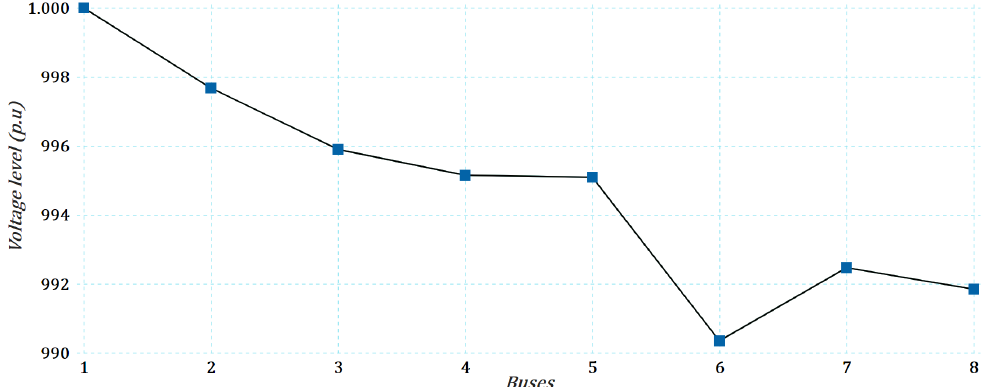
Figure 5. Voltage profiles in the buses for the IEEE 8-bus system